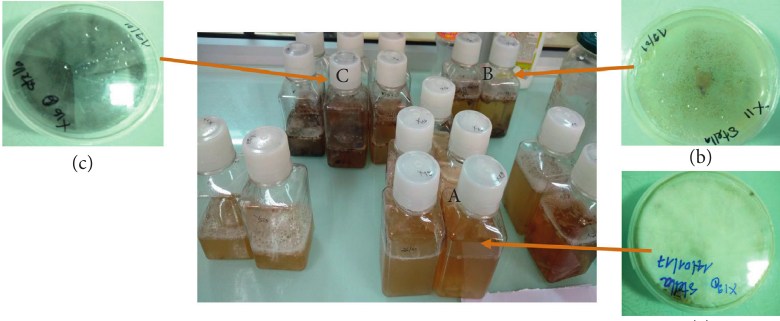
Figure 2: Fermentation procedure of the isolated strains in PDA broth at 25 ° C for 14 days. (A) Endophyte from stem bark of T. catappa (B) Endophyte from leaves of C. odorata , (C) Endophyte from leaves of T. mantaly . Table 1: The different metabolites extracted from the endophytic fungi and their corresponding plant material.